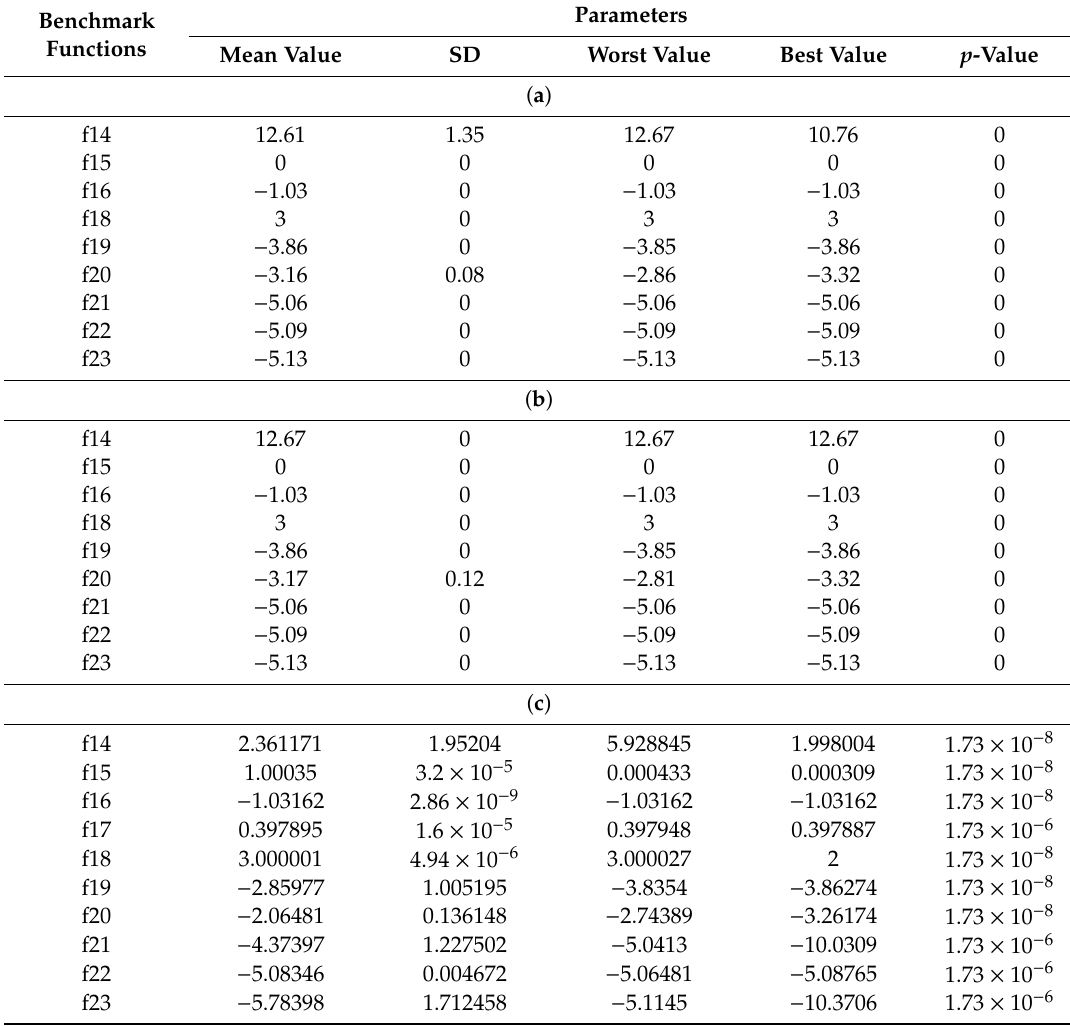
Table 8. ( a ) Outcomes of the BMFO1 algorithm. ( b ) Outcomes of the BMFO2 algorithm. ( c ) Outcomes of the HHO